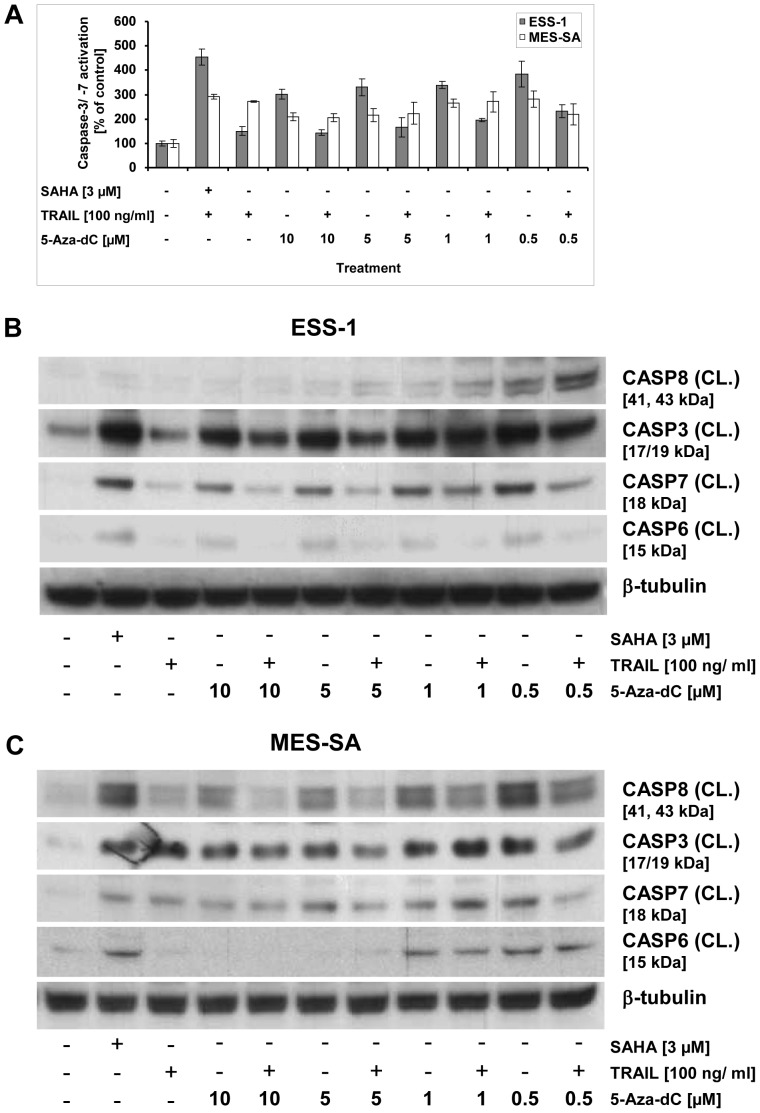
Reactivation of apoptosis through DNA demethylation by 5-Aza-dC in uterine sarcoma cells.Caspase-3 and -7 activation was measured in the uterine sarcoma cell lines, ESS-1 and MES-SA, upon DNA demethylation analysis (A). Therefore, treatment of cells with different concentrations (0.5, 1, 5, or 10 μM) of the DNA methylation inhibitor 5-Aza-dC was performed for 5 days with or without final addition of TRAIL (for 8 hours). Cells treated with 3 μM SAHA and/or 100 ng/ml TRAIL were included as positive controls. The cells received daily exchange of medium supplemented with fresh 5-Aza-dC whereas the control received no treatment at all. Western blot analysis of ESS-1 cells (B) and MES-SA cells (C) that were treated as in (A) for monitoring caspase activity upon DNA demethylation. Samples with 50 μg of protein were separated by SDS-PAGE (12% Bis-tris gel), transferred onto nitrocellulose membrane, and analyzed with antibodies against cleaved (CL.) caspases-3, -7, -6, -8, and β-tubulin as loading control. Untreated cells were used as control. The molecular weights of presented bands are indicated in brackets.